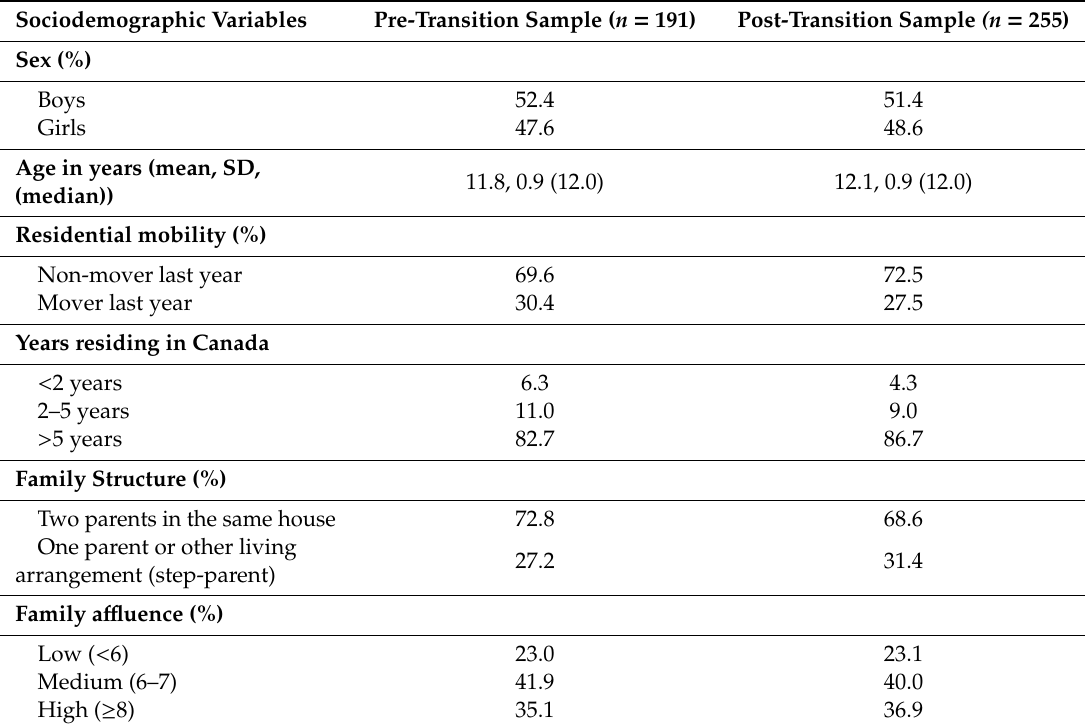
Table 1. Sociodemographic backgrounds of children before, after and across the school grade transition. Sociodemographic